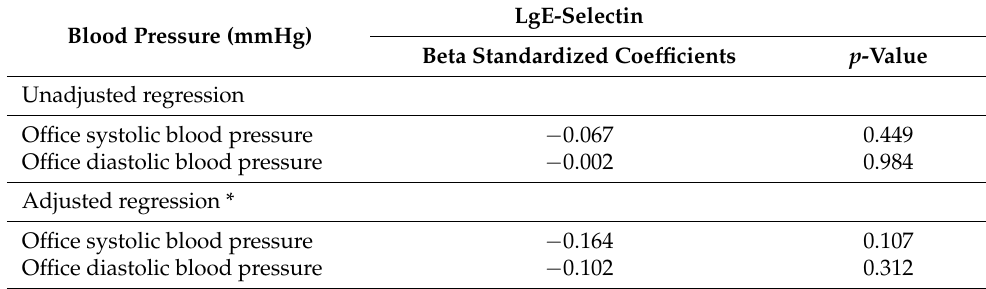
Figure 1. The relationship of E-selectin with office systolic ( A ) and diastolic ( B ) blood pressure. Table 3. Univariate linear regression analysis for the dependent variable lgE-Selectin using office blood pressure parameters as predictors.